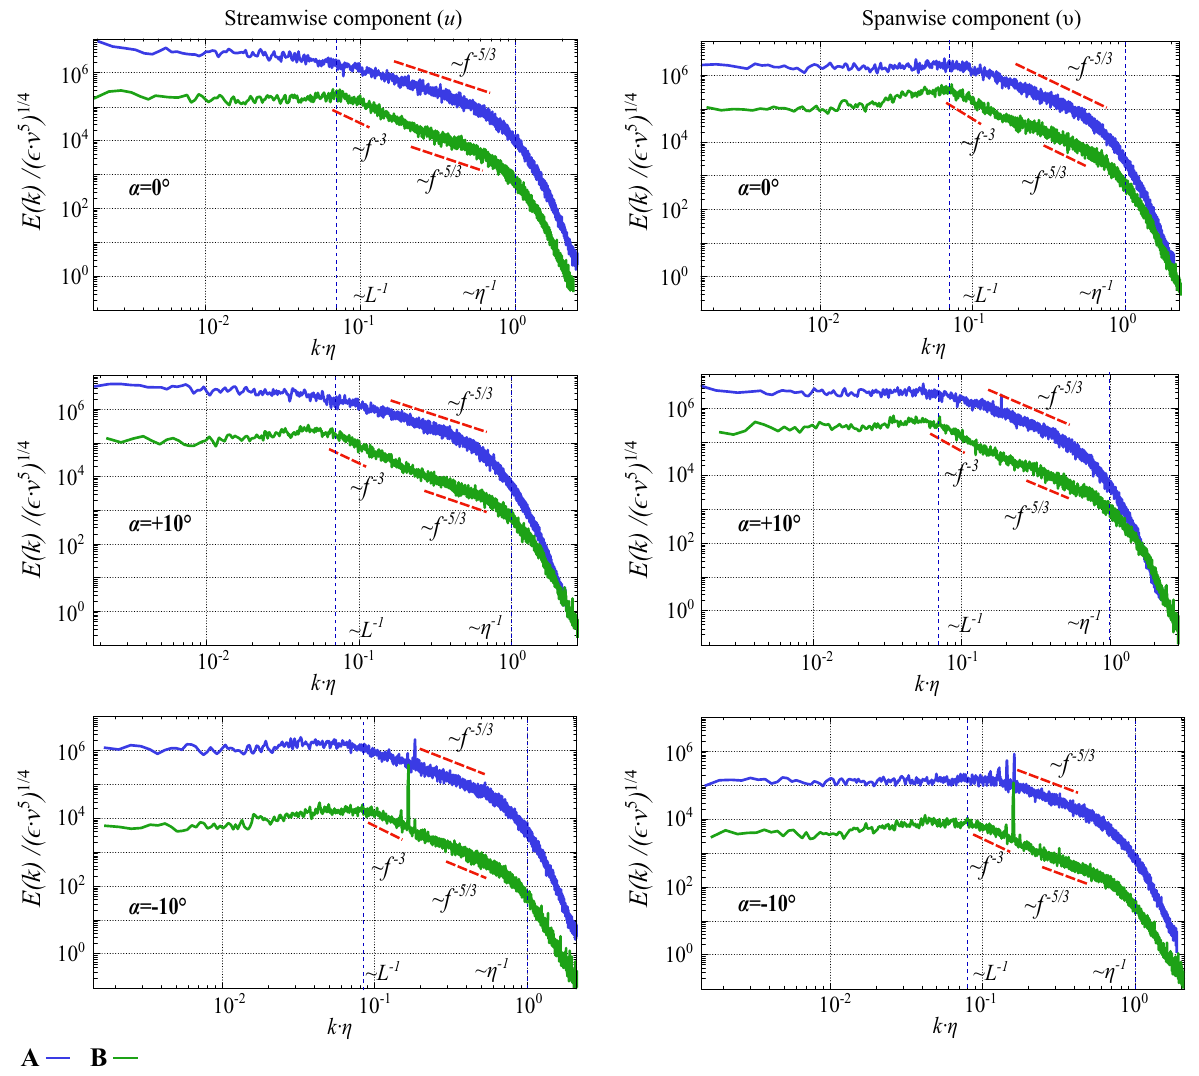
Fig. 8 Normalized Eulerian power spectral densities of straemwise and spanwise fluctuations depending on the angle of attack at x ⋅ c − 1 ≈ 0.2 and Re ≈ 1.7 ⋅ 10 5 . Green and blue color indicates the spectral density for measuring points A and B,